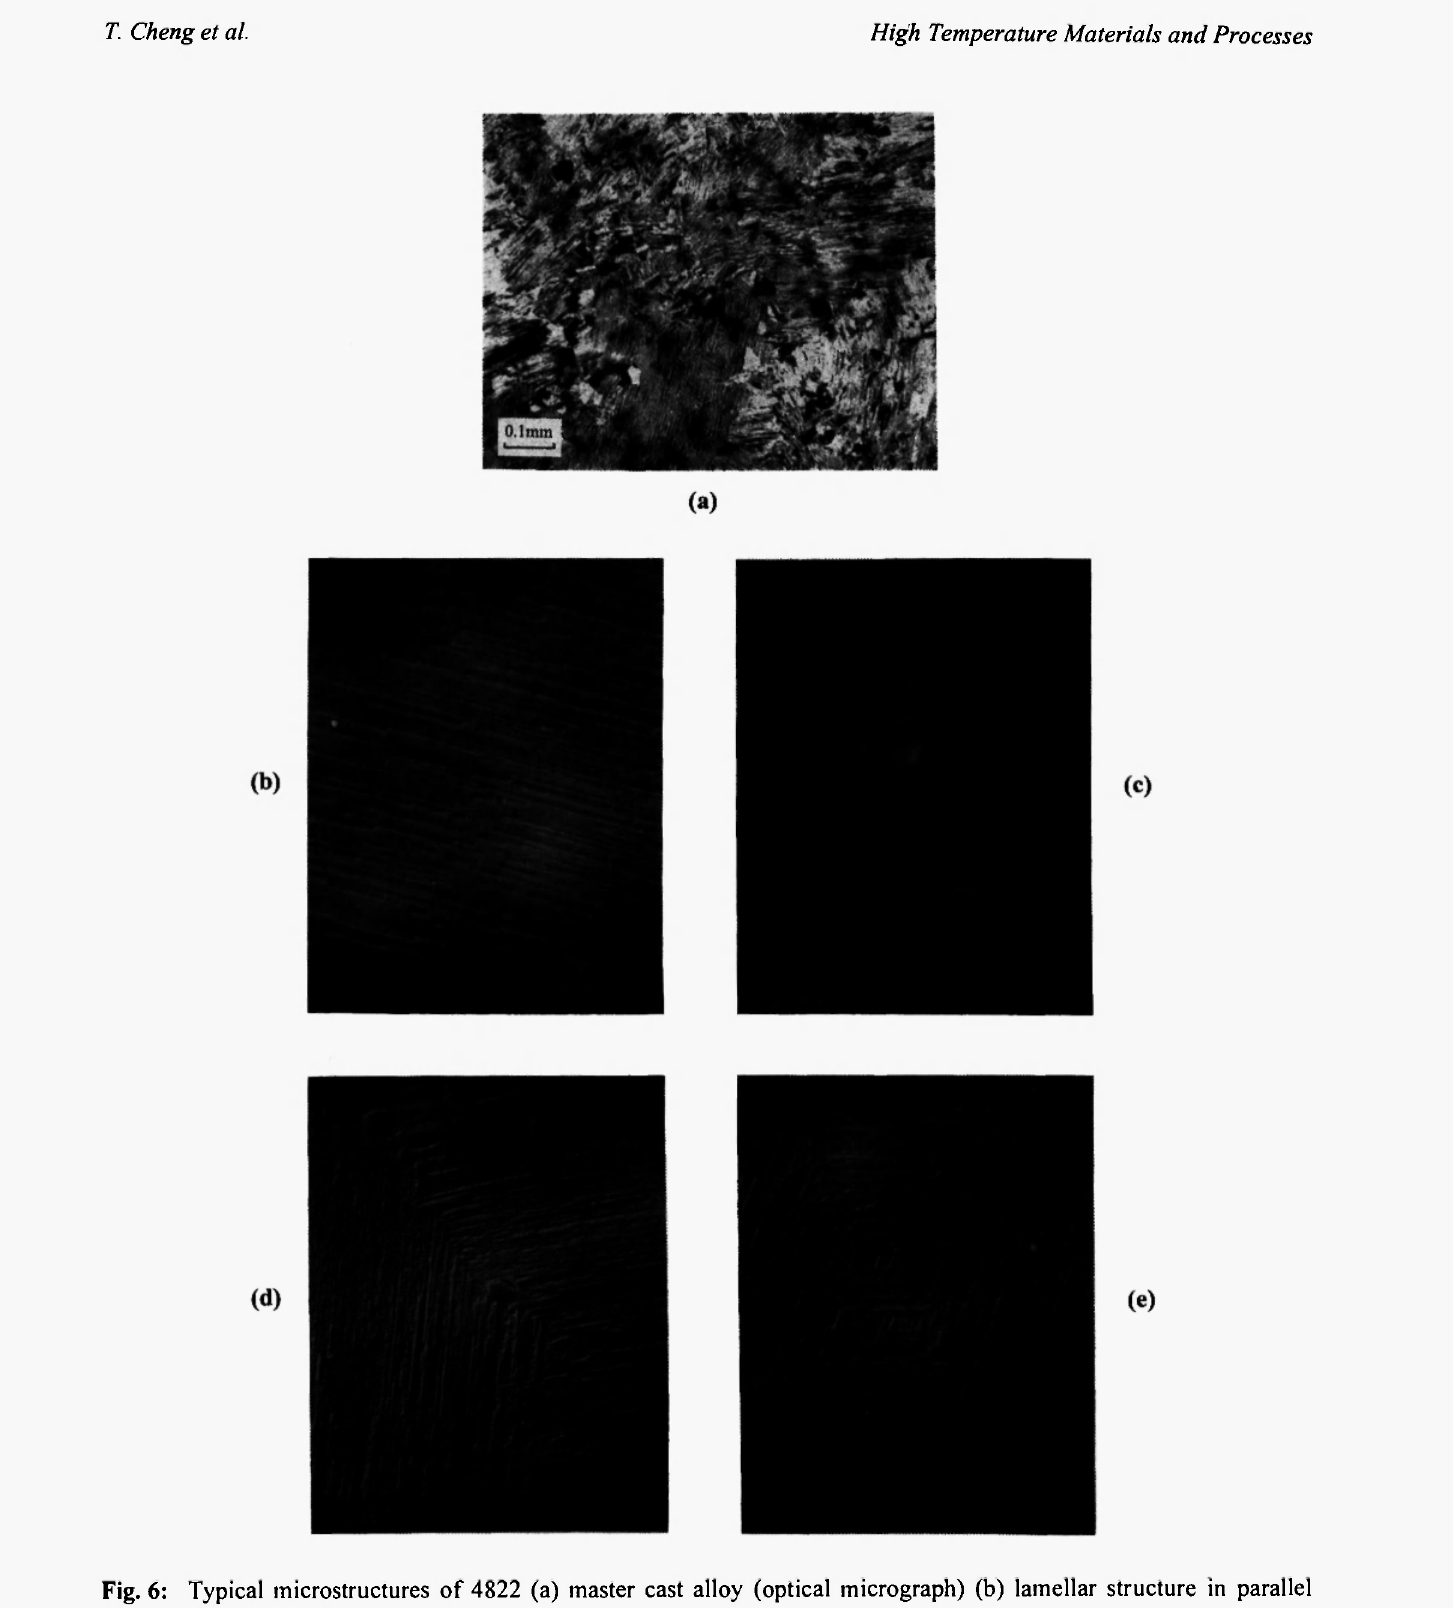
Fig. 6: Typical microstructures of 4822 (a) master cast alloy (optical micrograph) (b) lamellar structure in parallel columnar grains of 4822-2 (c) a few block-like γ (white) on grain boundaries in PD1 (backscattering image in SEM) (d) grain boundaries in 4822-6 (e) grain boundaries on 4822-2 ((b)(d)(e) secondary electronic image in SEM).